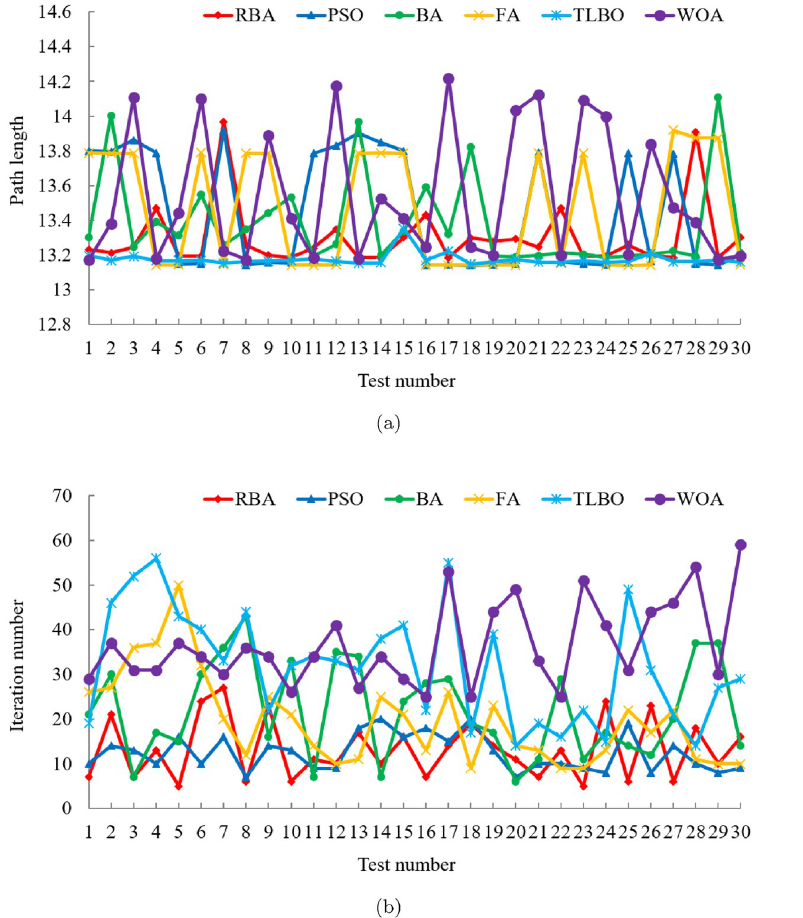
Fig 2. Experimental results of six algorithms in test case 1. (a) Path length. (b) Iteration number.